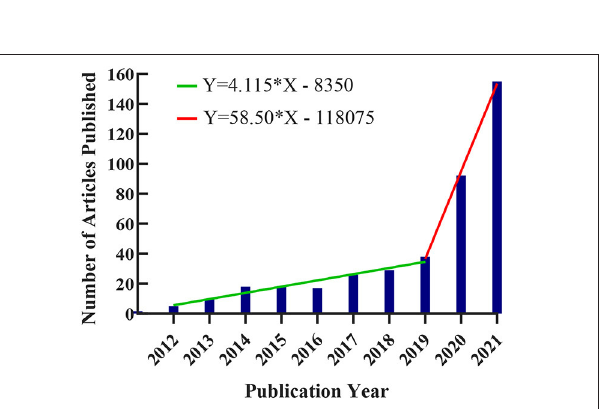
FIGURE 2 | Trends in the number of publications on applying VR to the study of nursing from 2012 to 2021. The number of documents issued each year is represented by the blue bar. The green and red trend lines, respectively, represent the trend in which the number of published documents remains stable and the trend in which the number of published documents increases